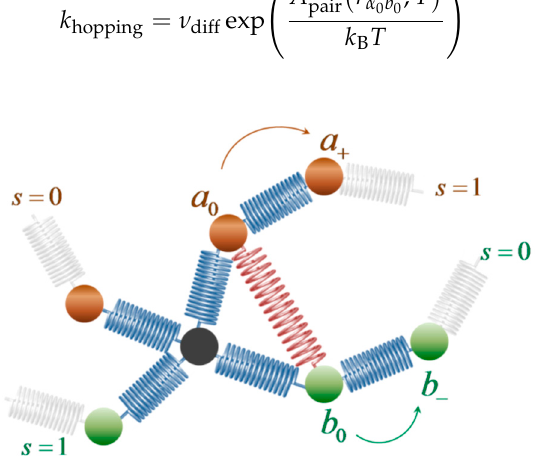
Figure 3. Schematic representation of the hopping scheme for slip springs along the chain contour in the event of crosslink presence in the polymer network (c.f. Figure 2 in reference [49] for the case of a polymer melt). All possible jumps are between first-neighbor beads only, whereas double jumps are not allowed.